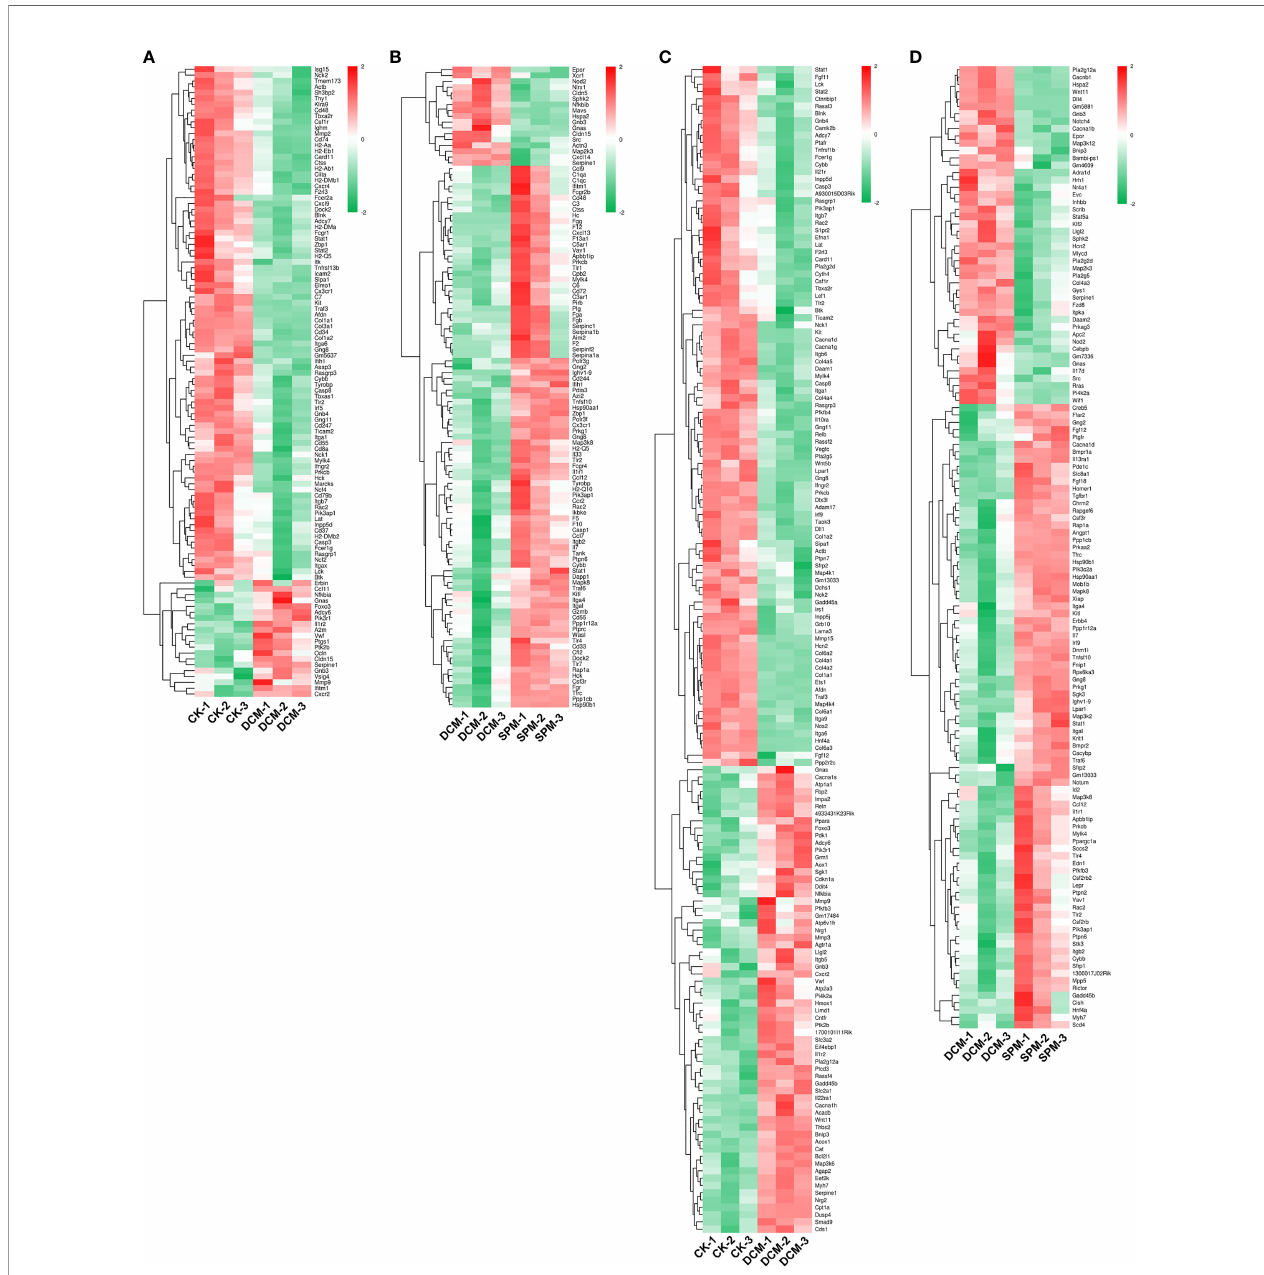
FIGURE 2 | Differential gene expressions in immune and signal-transduction-related pathways. Heat map shows the hierarchical clustering of DEGs in immunity- related pathways of (A) DCM compared to CK group and (B) SPM compared to DCM group. Heat map shows the hierarchical clustering of DEGs in signal transduction pathways of (C) DCM compared to CK group and (D) SPM compared to DCM group. In clustering analysis, up- and downregulated genes are colored in red and green,